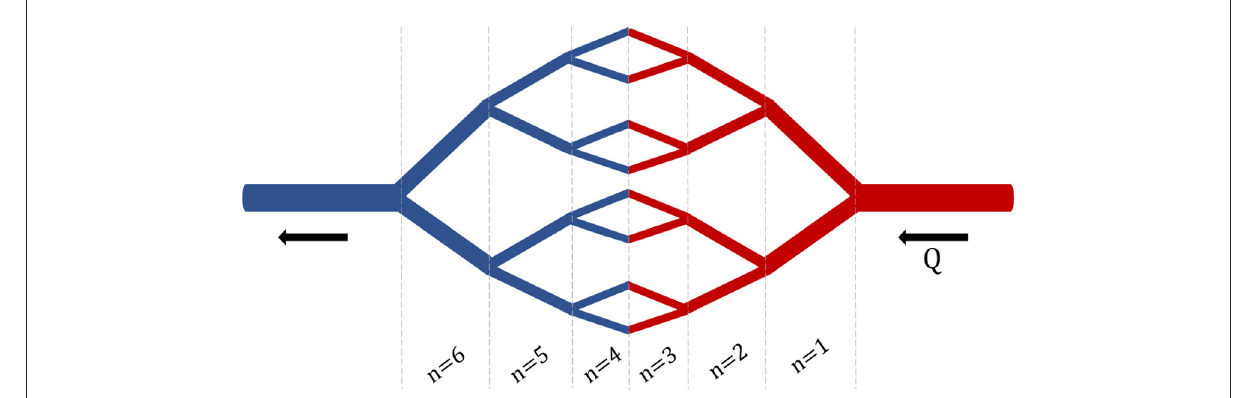
FIGURE3 Branched Network. An example branching network with i = 3 bifurcations and n = 6 generations.